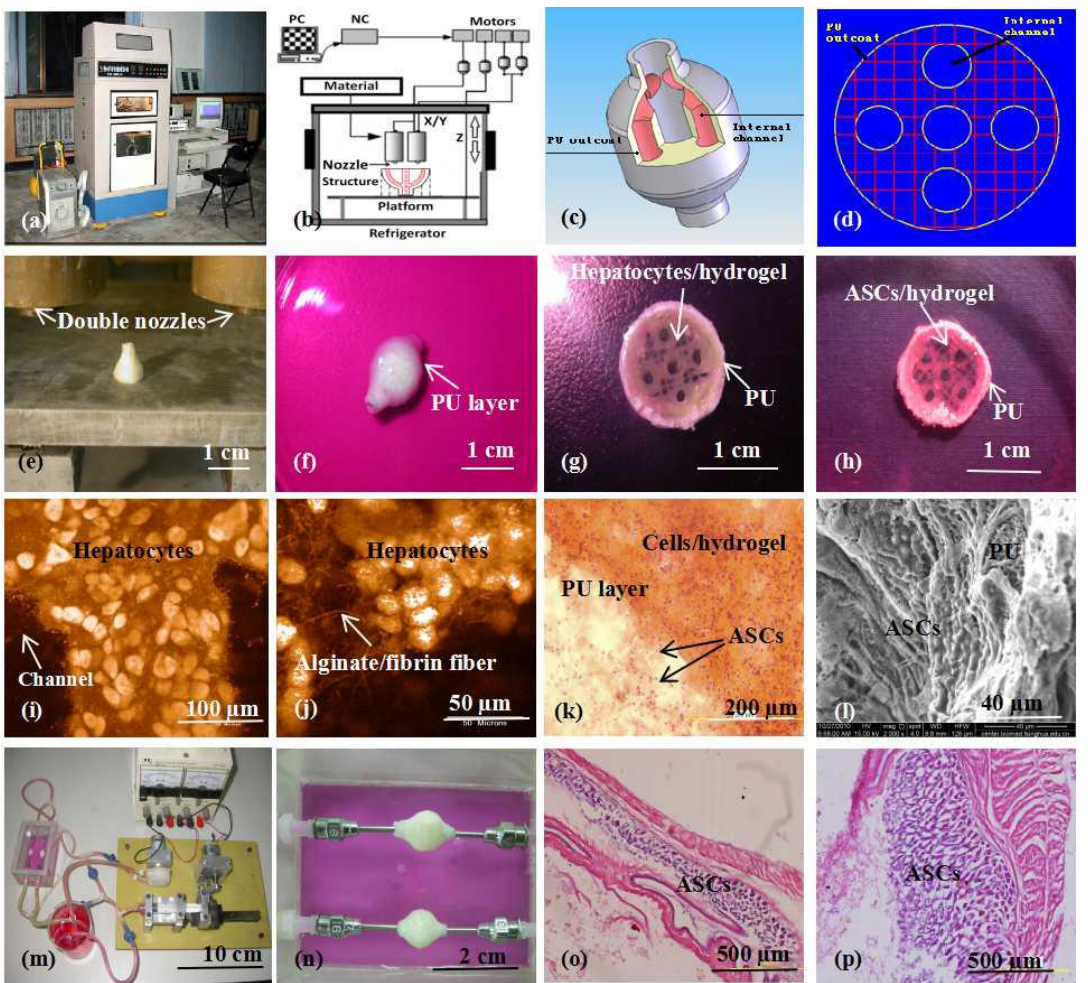
Figure 13. A large scale-up 3D printed complex organ with vascularized liver tissue constructed through the double-nozzle 3D printer created in Tsinghua University, Prof. Wang’s laboratory: ( a ) the double-nozzle 3D printer; ( b ) a computer-aided design (CAD) model containing a branched vascular network; ( c ) a CAD model containing the branched vascular network; ( d ) a cross section of the CAD model containing five sub-branched channels; ( e ) working platform of the 3D bioprinter containing two nozzles; ( f ) an ellipse sample containing both a cell-laden natural hydrogel and a synthetic polyurethane (PU) overcoat; ( g ) several layers of the ellipse sample in the middle section containing a hepatocyte-laden gelatin-based hydrogel and a PU overcoat; ( h ) several layers of the ellipse sample in the middle section containing an adipose-derived stem cell (ASC)-laden gelatin-based hydrogel and a PU overcoat; ( i ) hepatocytes encapsulated in the gelatin-based hydrogel; ( j ) a magnified photo of ( i ), showing the alginate / fibrin fibers around the hepatocytes; ( k ) ASCs encapsulated in the gelatin-based hydrogel growing into the micropores of the PU layer; ( l ) ASCs on the inner surface of the branched channels; ( m ) pulsatile culture of two ellipse samples; ( n ) two samples cultured in the bioreactor; ( o ) static culture of the ASCs encapsulated in the gelatin-based hydrogel; ( p ) pulsatile culture of the ASCs encapsulated in the gelatin-based hydrogel. Images reproduced with permission from